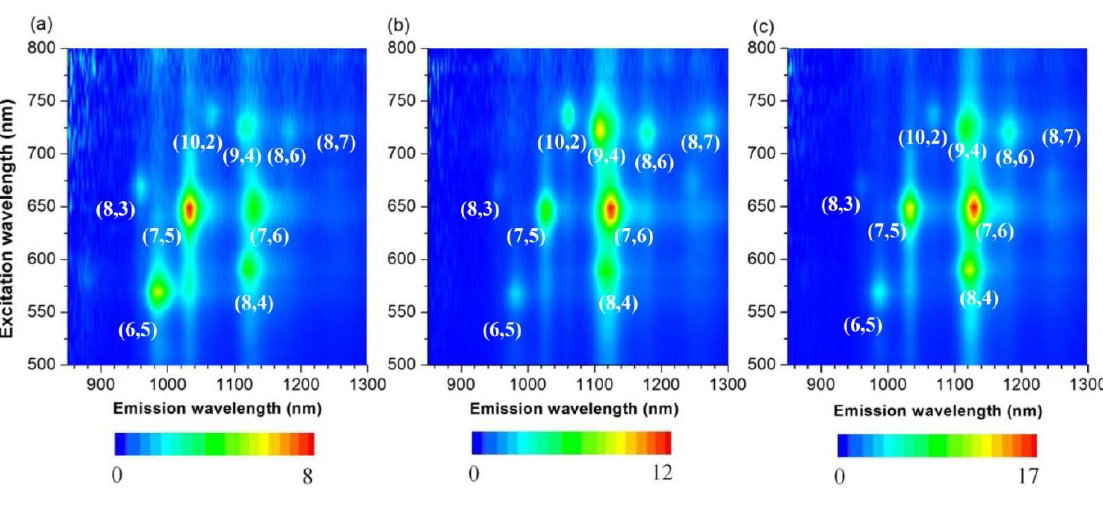
1. ( n , m ) Abundance estimated from photoluminescence (PL) spectra of semiconducting SWNTs before and after extraction of 76-CoMoCAT with ZnOEP and